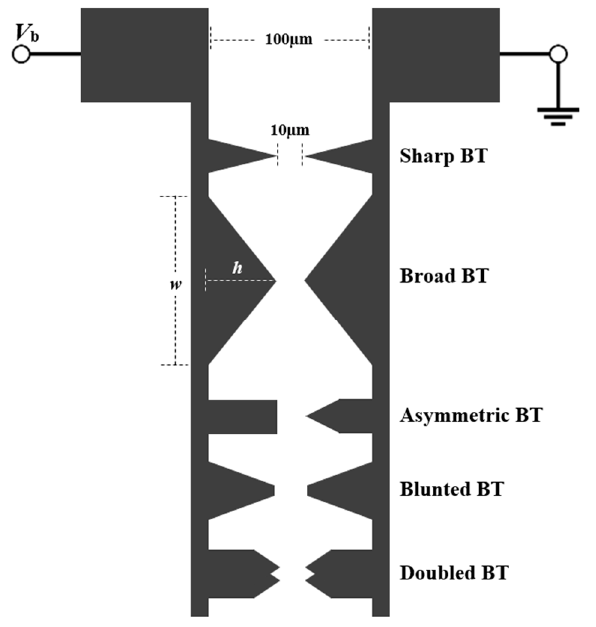
Figure 2. The five investigated structures, including Sharp BT, Broad BT, Asymmetric BT, Blunted BT, and Doubled BT antenna structures.